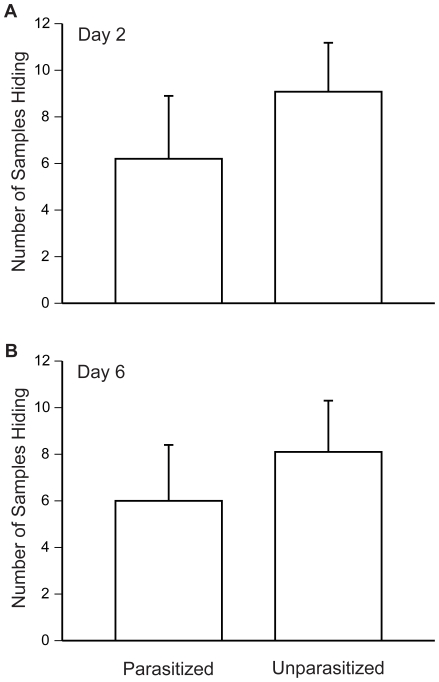
Number of sampling periods in which female crickets were hiding.We found no difference in the number of sampling periods in which parasitized and unparasitized female crickets were hidden under a shelter on either day 2 (A) or day 6 (B) in the activity patterns experiment. Means plus one standard error are shown.